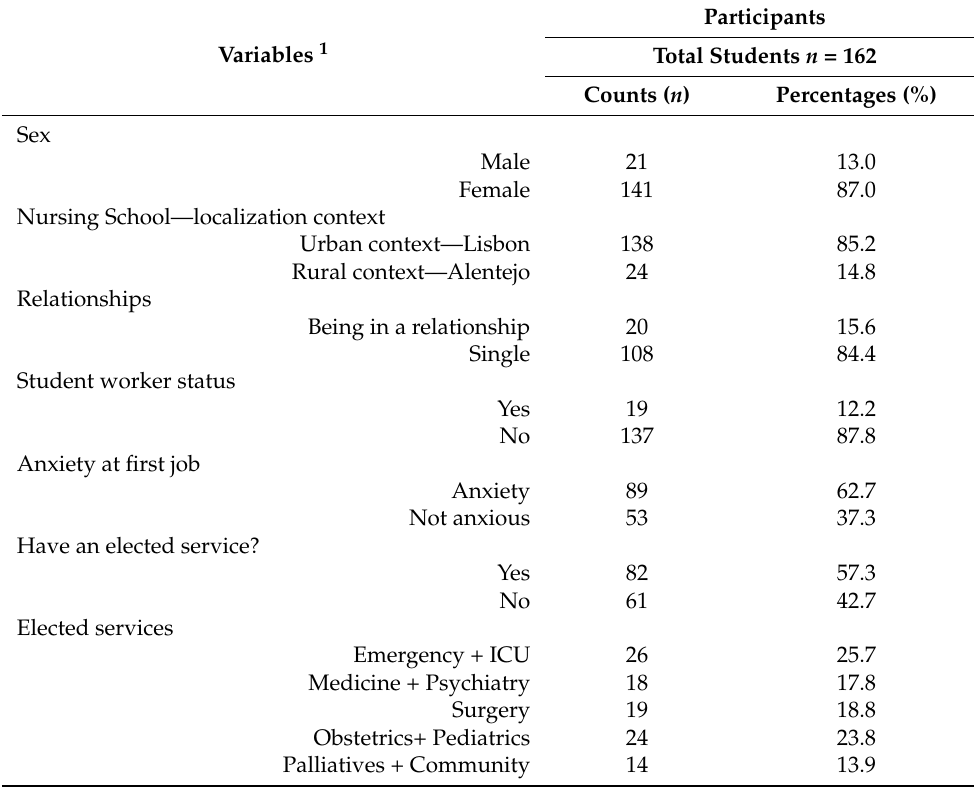
Table 1. Participants’ characteristics.